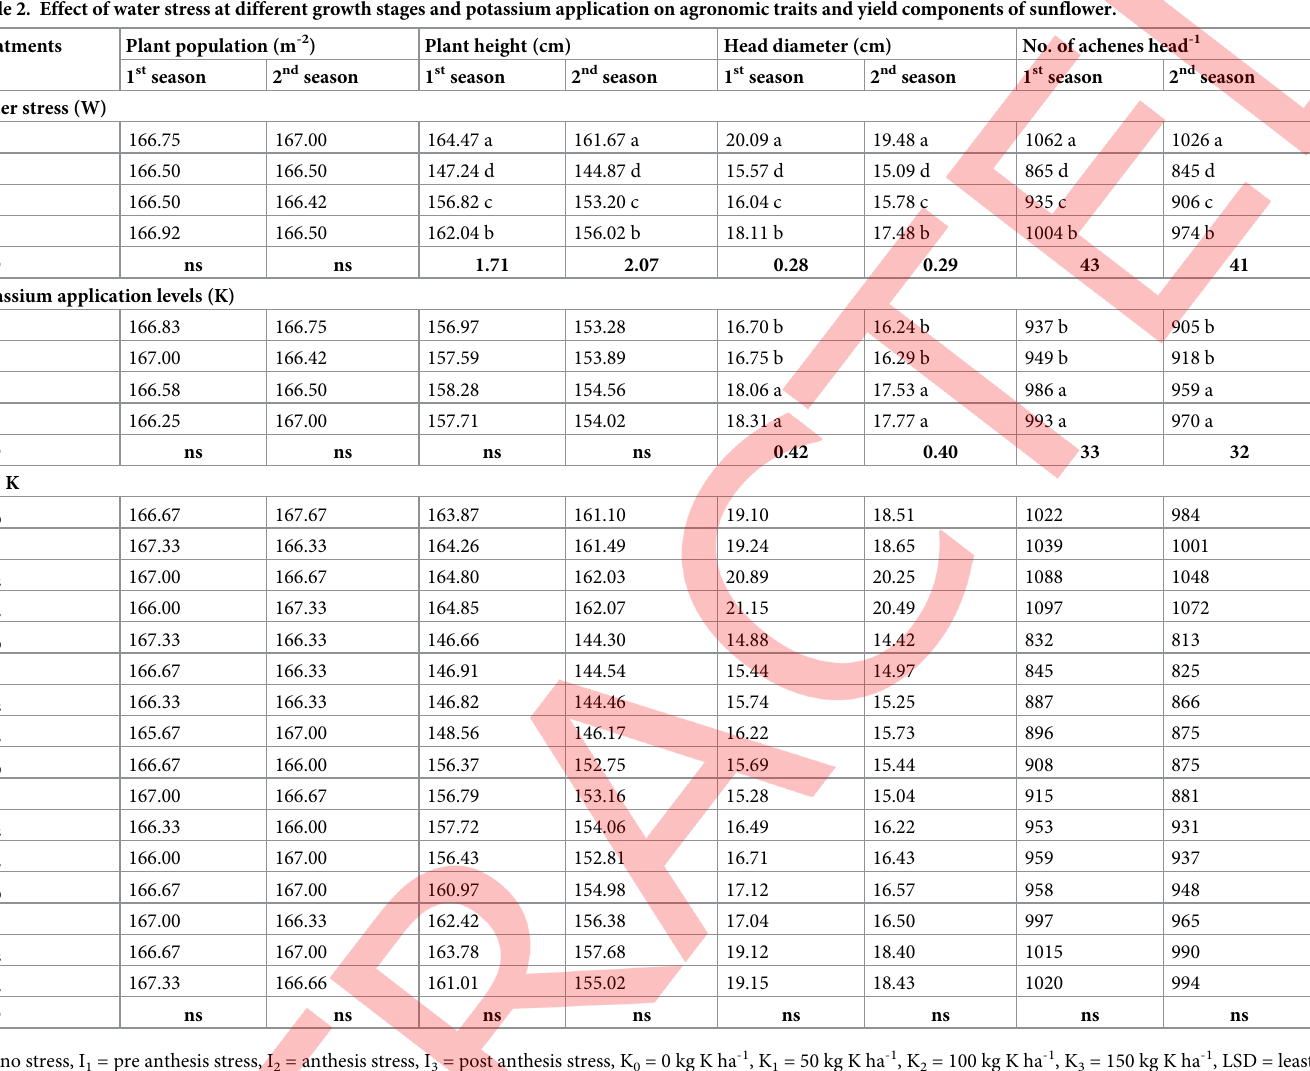
Table 2. Effect of water stress at different growth stages and potassium application on agronomic traits and yield components of sunflower. Treatments Plant population (m -2